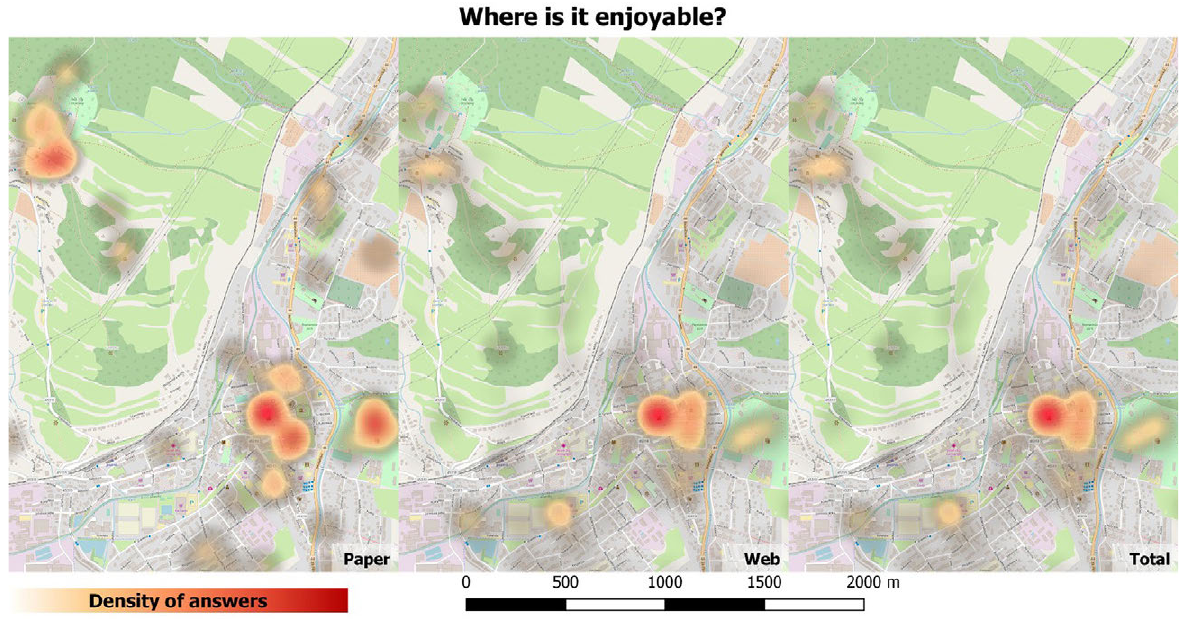
Fig. 4. Where do respondents think it is enjoyable in Jeseník?